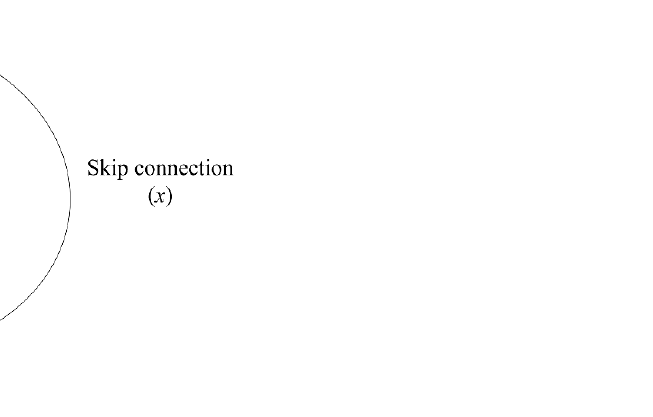
Figure 5. Fine-tuned VGG16 architecture.